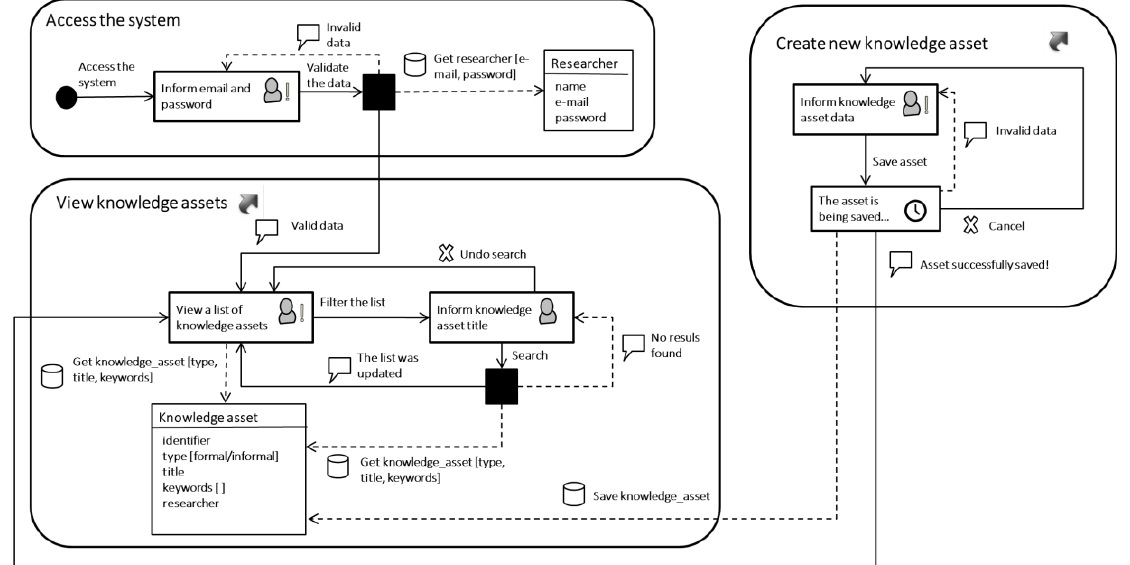
Fig. 2. USINN diagram